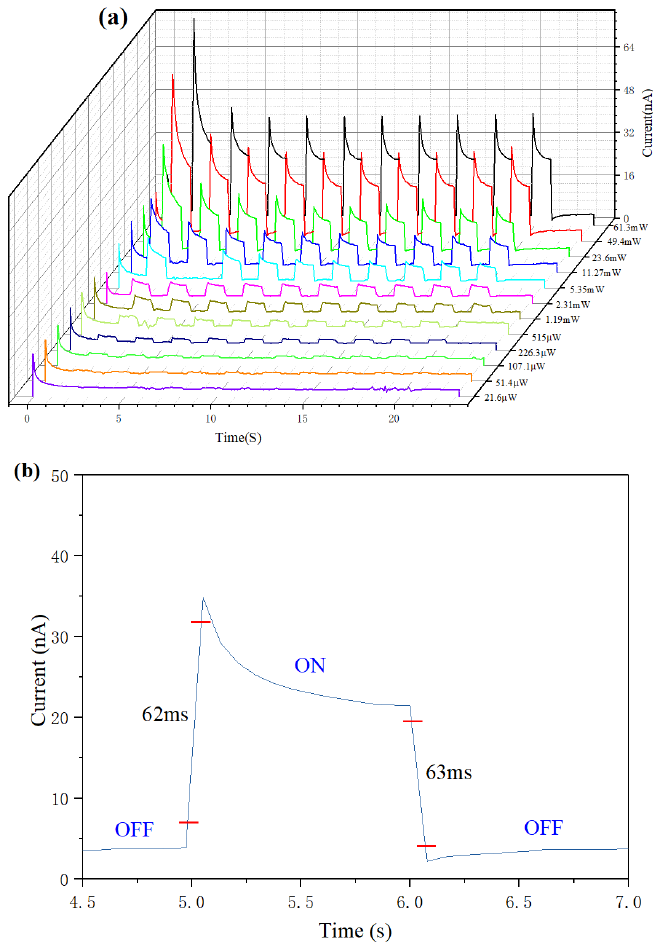
Figure 5. ( a ) Photoresponse characteristics under zero-bias 532 nm laser. ( b ) Response time of HDA-BiI 5 -based photoelectric devices at the wavelength of 532 nm and a power of 49.4 mW. As can be seen in Figure 6, the photoresponsivity increases rapidly with decreasing light power, and importantly, a high photoresponsivity of 130 μA/W is observed even at very low light power, which indicates that our photodetector provides low power con- sumption characteristics. With increasing photopower, the photocurrent has a depend- ence on it. The decrease in photoresponsivity can be explained by the presence of trap states at the interface between HDA-BiI 5 and NiO x and the attachment of charged impu- rities or molecules on the HDA-BiI 5 film [34]. Under the illumination of high light power, the density of available states decreases and photoinduced carriers can fill more traps, leading to saturation of the photoresponse [35,36]. In addition, probably due to the effect